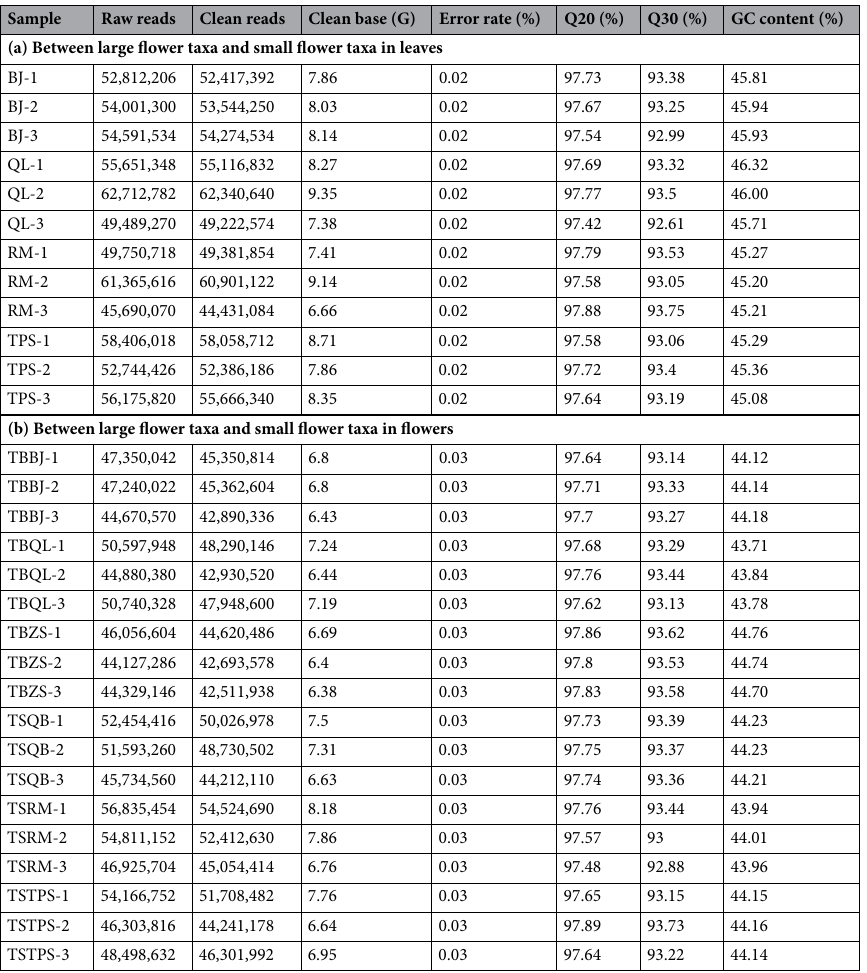
Table 1. Summary of the analysis of transcriptome sequences. (a) Large flower taxa: BJ and QL; small flower taxa: RM and TPS, all samples information is listed in Supplementary Table S4. (b) Large flower taxa: TBBJ, TBQL and TBZS; small flower taxa: TSQB, TSRM and TSTPS, all samples information is listed in Supplementary Table